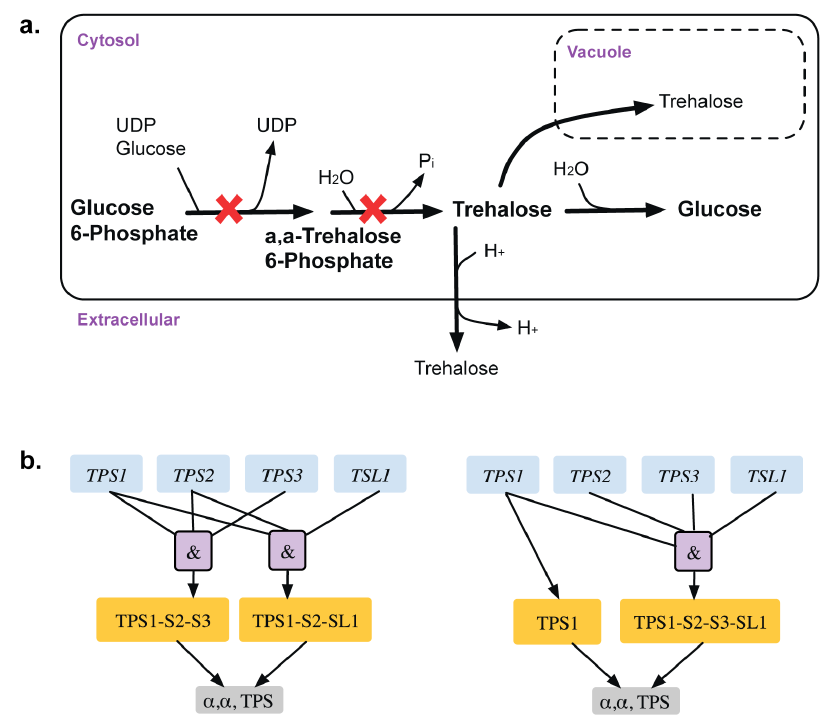
Figure 3. Trehalose metabolism. ( a ). Trehalose biosynthetic pathway with essential reactions marked with a red cross. ( b ). GPR modification revealing that TPS1 gene is only essential for the associated reactions in minimal glucose medium. Old GPR is shown on the left and new GPR on the